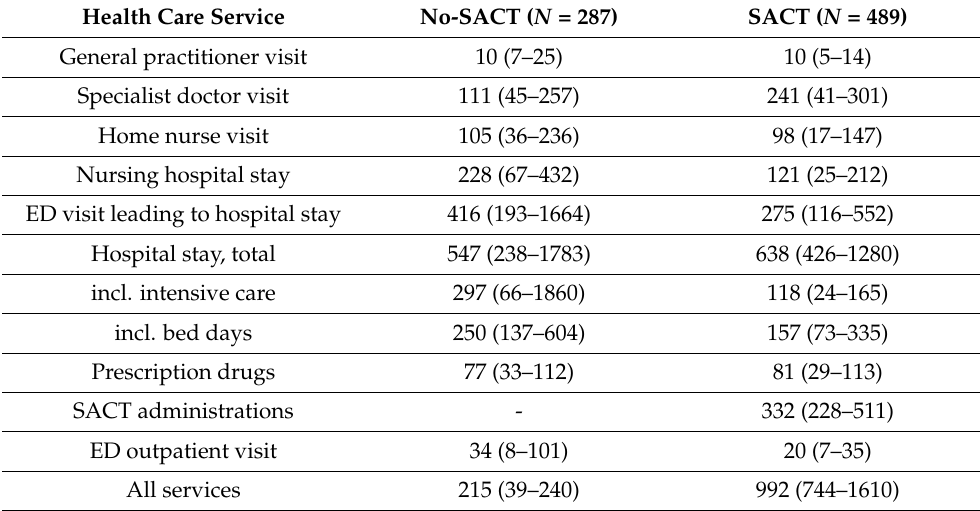
Table 3. Average per capita costs in euros (Q25–Q75) of different health care services per